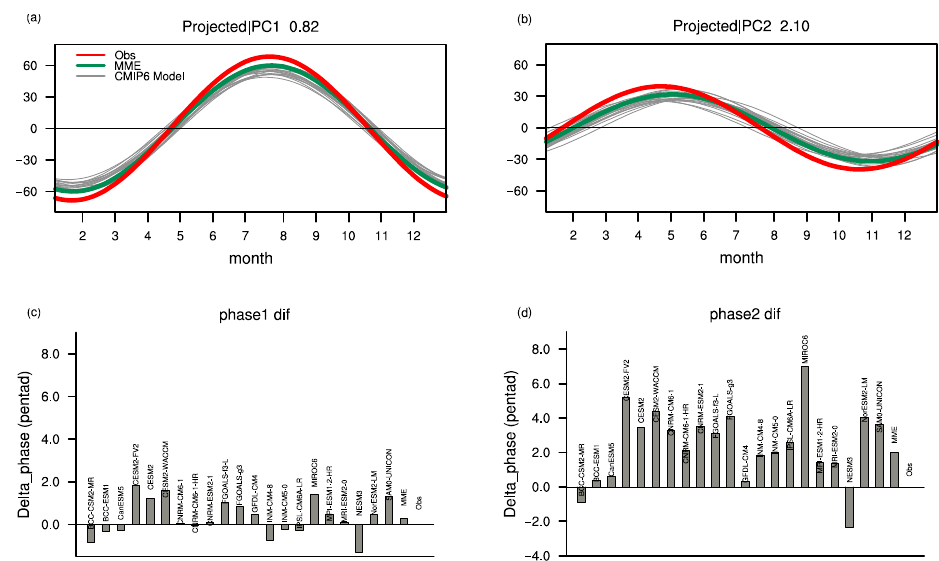
Figure 7. Projection principal component series (projected PCs) onto the observed ( a ) annual cycle M1 and ( b ) M2. The red, green, and gray curves represent the projected PCs in the observation, MME mean, and individual models, respectively. The timing of the maximum equal to the phase of trigonometric functions, which indicates the projected phase of the annual cycle mode in simulations. ( c , d ) Phase biases for M1 and M2. The phase biases are measured by the mathematic difference of maximum timing between the simulations and observations in ( a , b ). The sub-title numbers in ( a , b ) represent the inter-model standard deviations of the phase biases for M1 (0.82) and M2